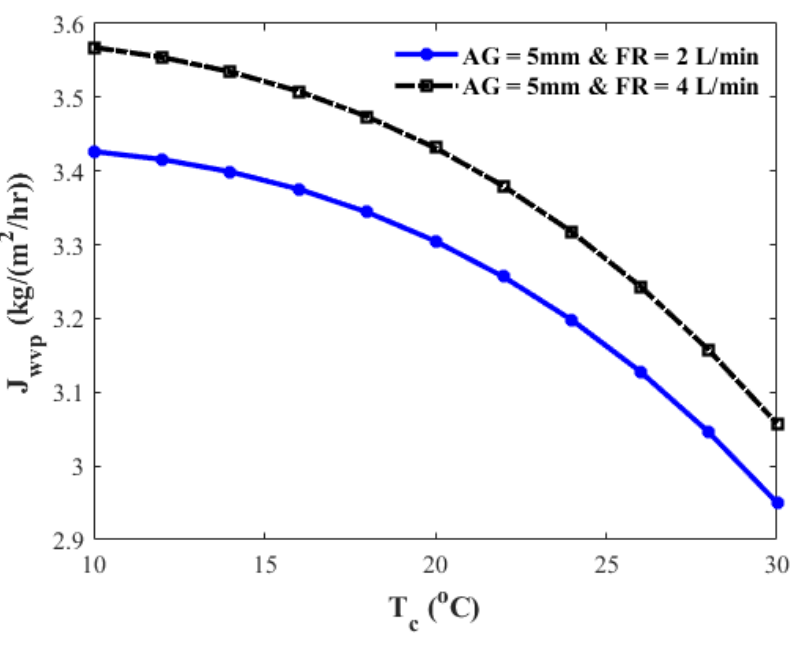
Figure 11. Effect of the hot feed (FR = 2 and 4 L/min) on the J wvp at different cold feed temperatures (T c ) (air gap thickness (AG) of 5 mm).